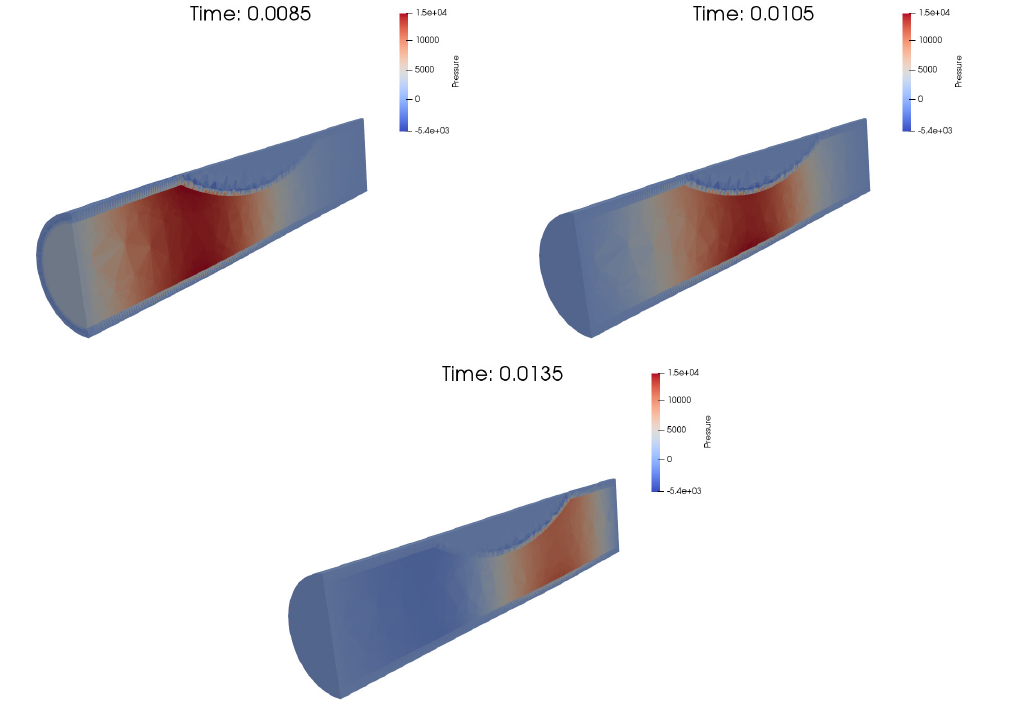
Figure 10. The computed pressure obtained with Mesh 3